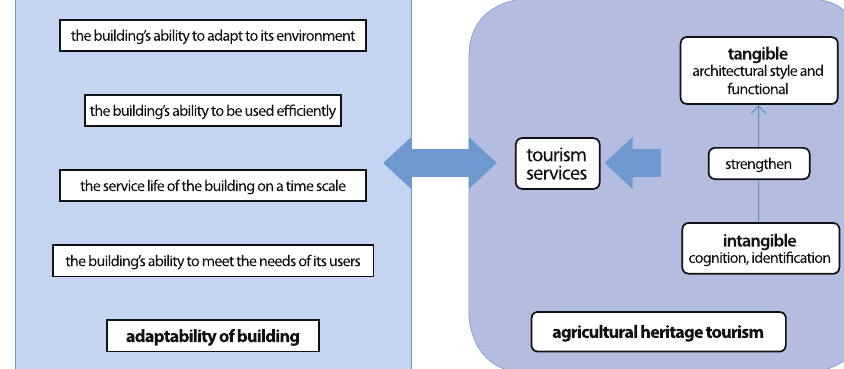
Fig. 1 Relationship between the adaptability of buildings and agric ultural heritage tourism (Source: the